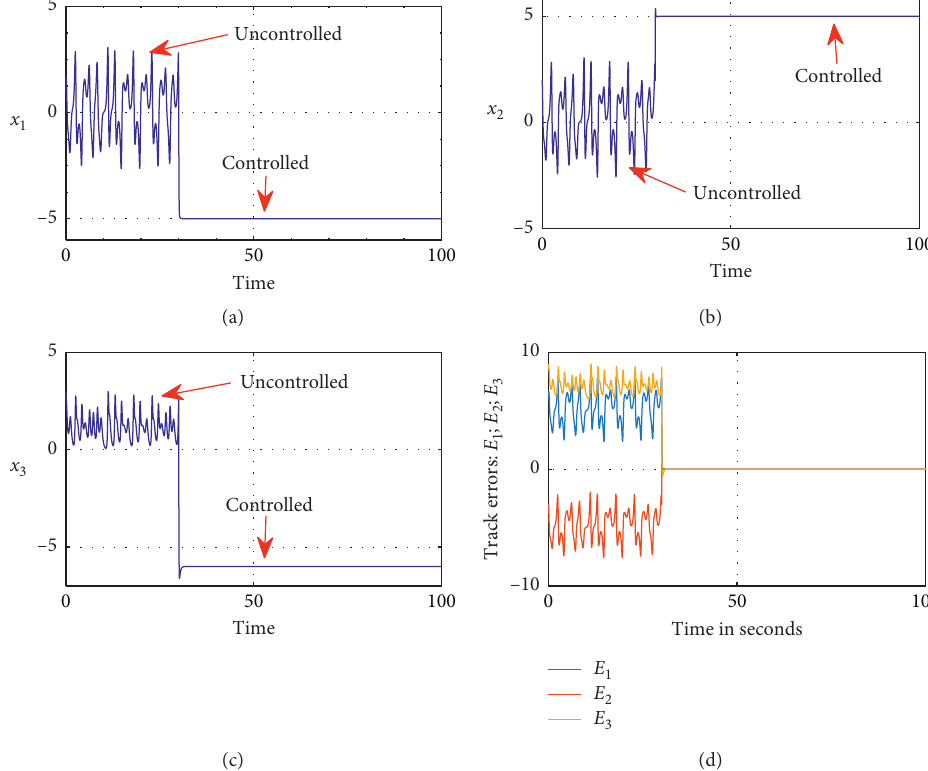
� − 5 ; x � 5 ; x � − 6: (a) the state variable x 1 r 2 r 3 r before and after control; (d) track errors before and after control. 3